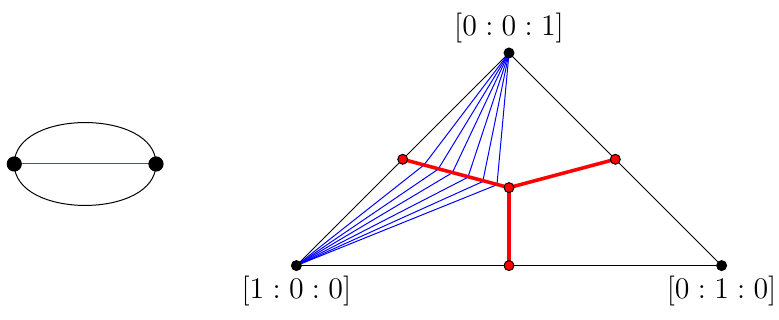
Figure 1 . The sunrise graph G and the simplex ∆ G ⊂ P G = P ( C 3 ) . The red part is the spine of ∆ , the simplicial/cubical complex on the central vertex w G lines indicate the fibers over the cube C G/ { e i , e j } , are the faces at